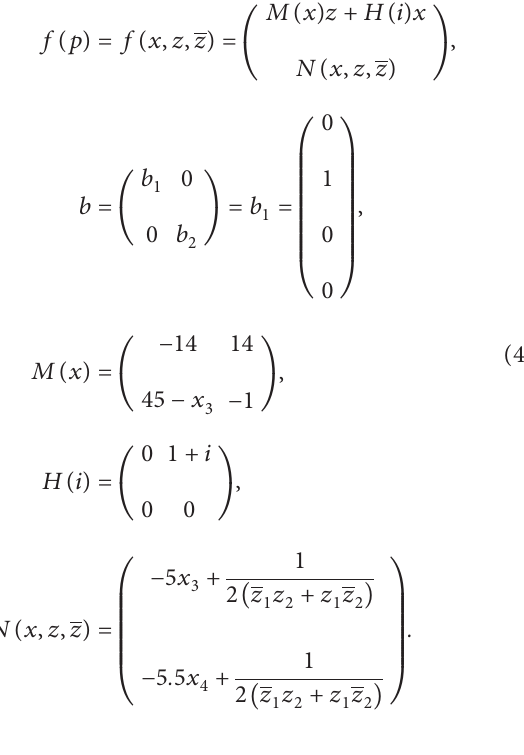
and y are asymptotically 4 5